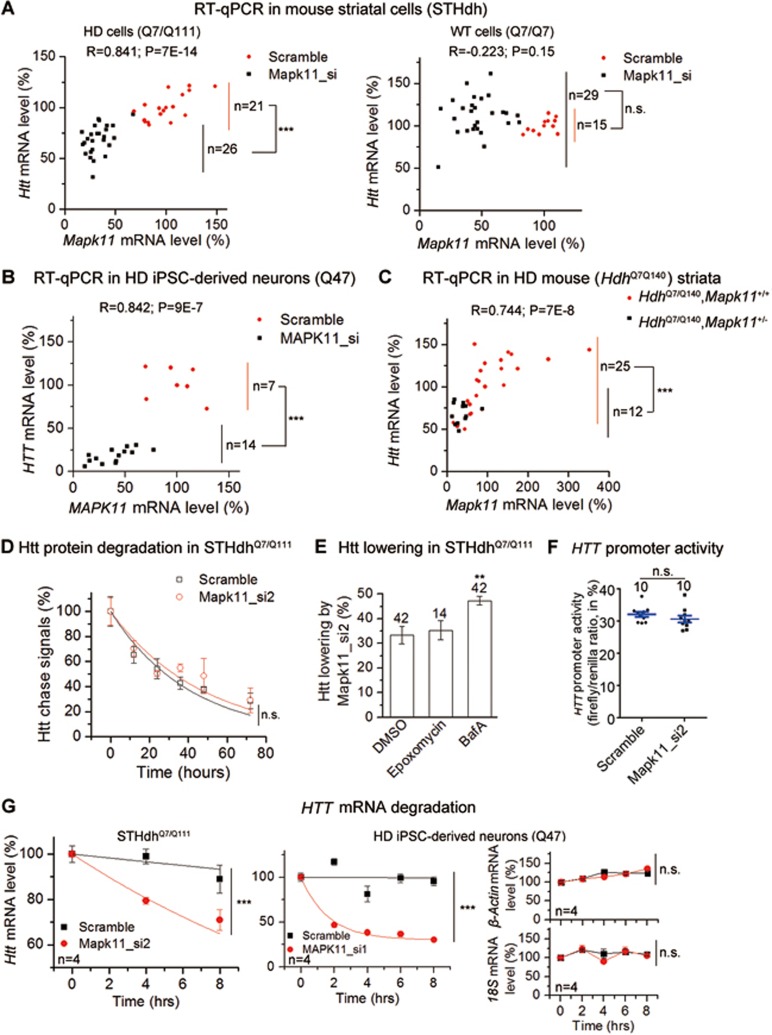
Mapk11 regulates HTT mRNA levels via regulation of HTT mRNA stability. (A) RT-qPCR results in STHdh cells showing that knockdown of Mapk11 lowers Htt mRNA levels in HD (left) but not wild-type cells (right). The X-axis indicates the Mapk11 mRNA expression level, whereas the Y-axis indicates the Htt mRNA level. As for B-D. Each single point exhibits the Htt versus Mapk11 mRNA levels of an independently transfected well, and the numbers are indicated (n). All data were normalized to the average of scrambled siRNA-transfected control samples. Red, scrambled siRNA-transfected control samples; Dark, cells transfected with either of the two Mapk11 siRNAs (Mapk11_si1&Mapk11_si2). The correlation coefficient R and P values on top of each plot were calculated by Spearman correlation analysis. “***” on the right side of each plot indicates that P< 0.001 calculated by unpaired two-tailed t tests for the Htt mRNA levels in Mapk11 siRNA-transfected sample versus the control. (B) Similar to (A), but in HD patient iPSC-derived neurons (Q47). Data plots and statistical analysis were performed in the same way as in (A). (C) Similar to (A), but the mRNAs were extracted from in vivo mouse striata (HdhQ7/Q140 with or without heterozygous knockout of Mapk11, 4-6.5-month-old), and the statistical analyses were performed the same. The “n” numbers indicate the number of mice. (D) The non-radioactive pulse-chase experiment showing that knockdown of Mapk11 does not influence Htt protein degradation. The siRNAs were transfected in STHdhQ7/Q111 cells. Three independently transfected wells for each point were tested. Data plotted as mean and SEM. The statistical analysis was performed by two-way ANOVA to determine if the transfection influences the protein degradation. “ns” on the right side of the plot indicates no statistically significant interaction between siRNA transfection and Htt protein degradation. (E) The Htt lowering by Mapk11 siRNA (Mapk11_si2) was measured in STHdh cells by 2B7/2166 HTRF. The proteasome inhibitor epoxomycin or the autophagy inhibitor bafilomycin A (BafA) did not reduce the lowering effect given by Mapk11 knockdown. Bars represent mean and SEM, and the numbers indicate the number of independently transfected wells. The statistical analysis was performed by one-way ANOVA and Dunnett's post hoc tests. **P< 0.01. (F) The Htt promoter activity was measured in STHdhQ7/Q111 by the luciferase reporter assay (see Materials and Methods). Knockdown of Mapk11 did not significantly influence the Htt promoter activity. Blue lines represent mean and SEM, and 10 independently transfected wells were tested for each condition. The statistical analysis was performed by unpaired two-tailed t tests. (G)
Htt mRNA stability measurements in STHdhQ7/Q111 cells (left) and HD patient iPSC-derived neurons Q47 (right). The cells were transfected with indicated siRNAs for 36 h and then treated with actinomycin D to stop new mRNA synthesis. The Htt/HTT mRNA level was then measured at different time points using RT-qPCR, normalized to Hprt/HPRT mRNA levels and plotted as percentage of the initial time point. For HD patient iPSC-derived neurons, β-actin and 18S mRNA were used as controls, which were not influenced by MAPK11 knockdown. Since their degradation is close to HPRT and their levels were normalized to HPRT at each time point, the normalized levels were relatively flat across time points. Data were plotted as mean and SEM. The statistical analysis was performed by two-way ANOVA to determine if the transfection influences the mRNA degradation. ***P< 0.0001 for the effect of MAPK11 siRNA on Htt mRNA degradation.